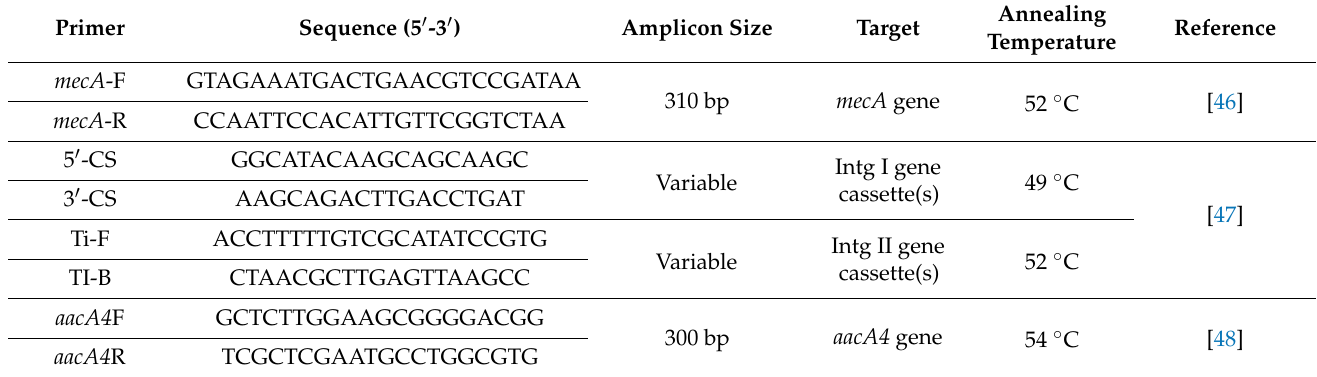
Table 3. Primers and amplicon size for mecA gene, integron class I, class II and aacA4